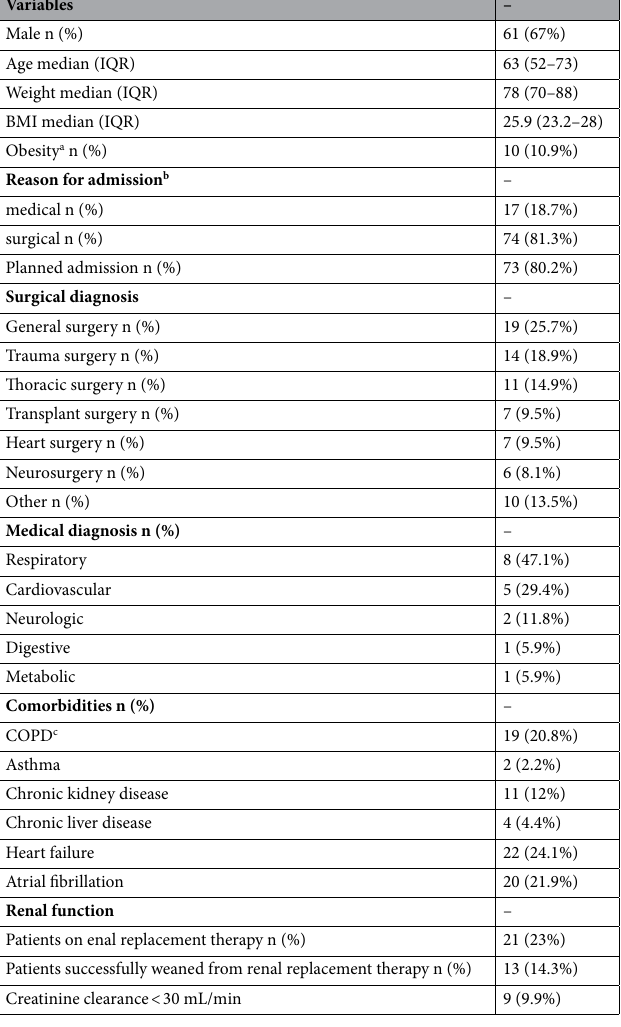
Table 1. Patients’ main characteristics. IQR interquartile range, BMI body mass index. a BMI > 30 kg/m 2 . b from the primary diagnosis for the ICU admission. c Chronic obstructive pulmonary disease.